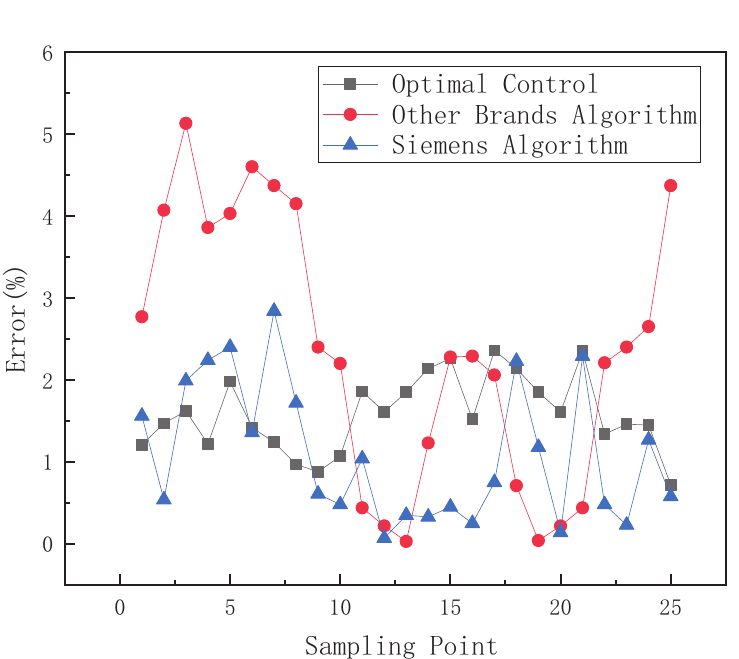
Figure 19. Small-range control algorithms